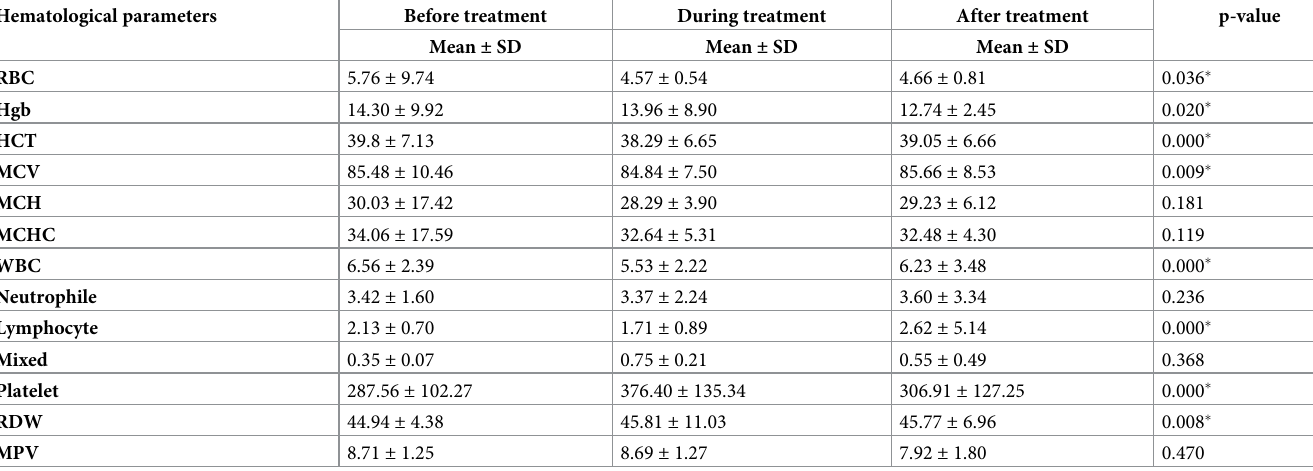
Note � P value less than 0.05 is a significance level.